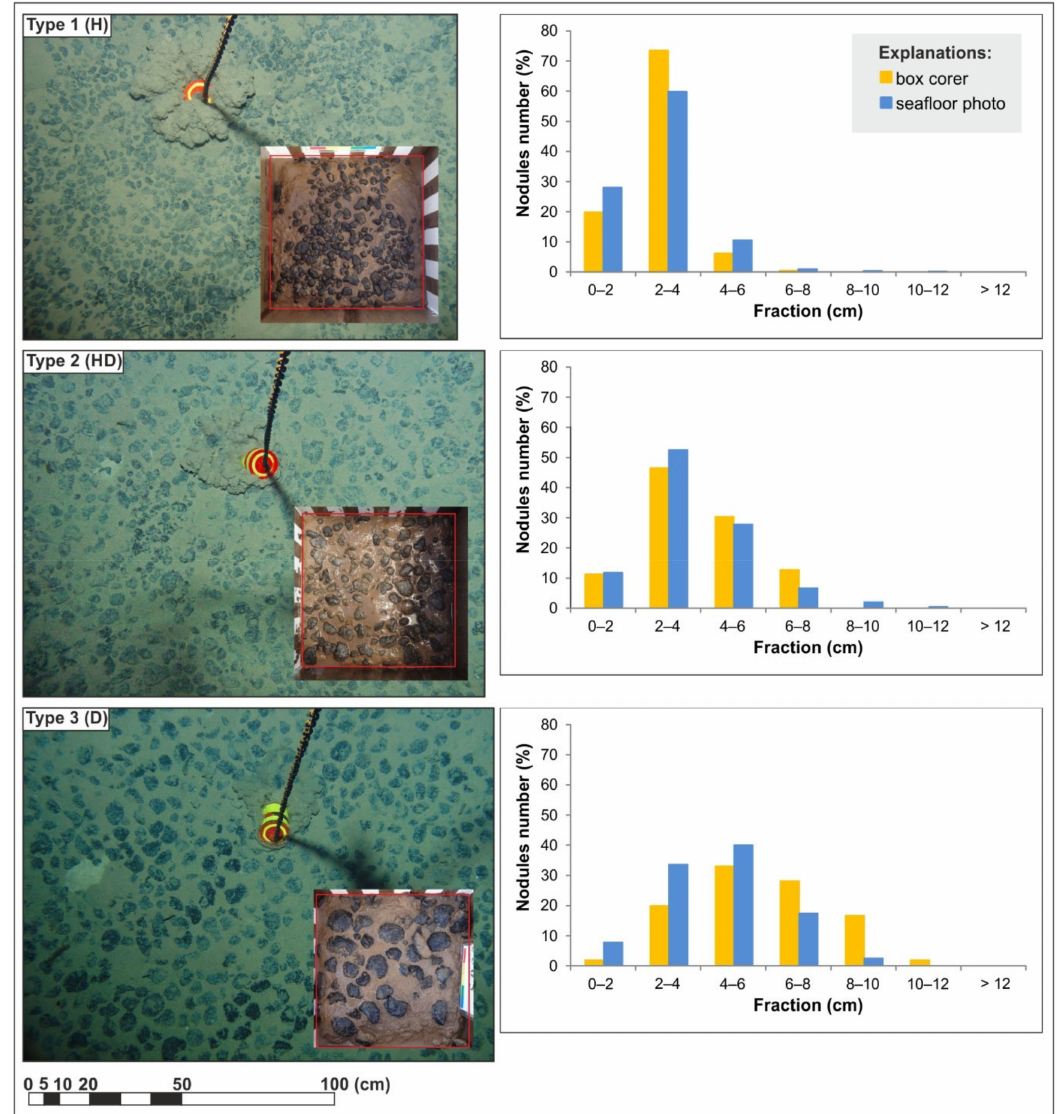
Figure 9. Seafloor and box corer photographs for three genetic types of nodules ( left ); fraction distributions of nodules defined on the basis of the box corer and seafloor photographs ( right